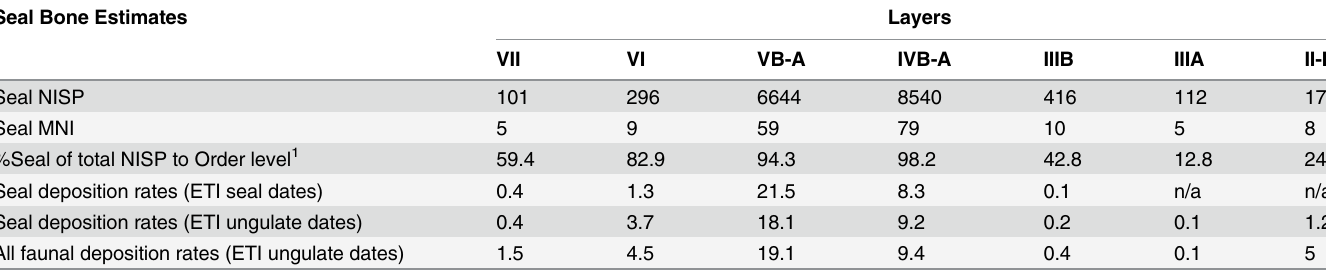
Table 3. Summary of faunal data for Sagan-Zaba II including deposition rates of seal remains.